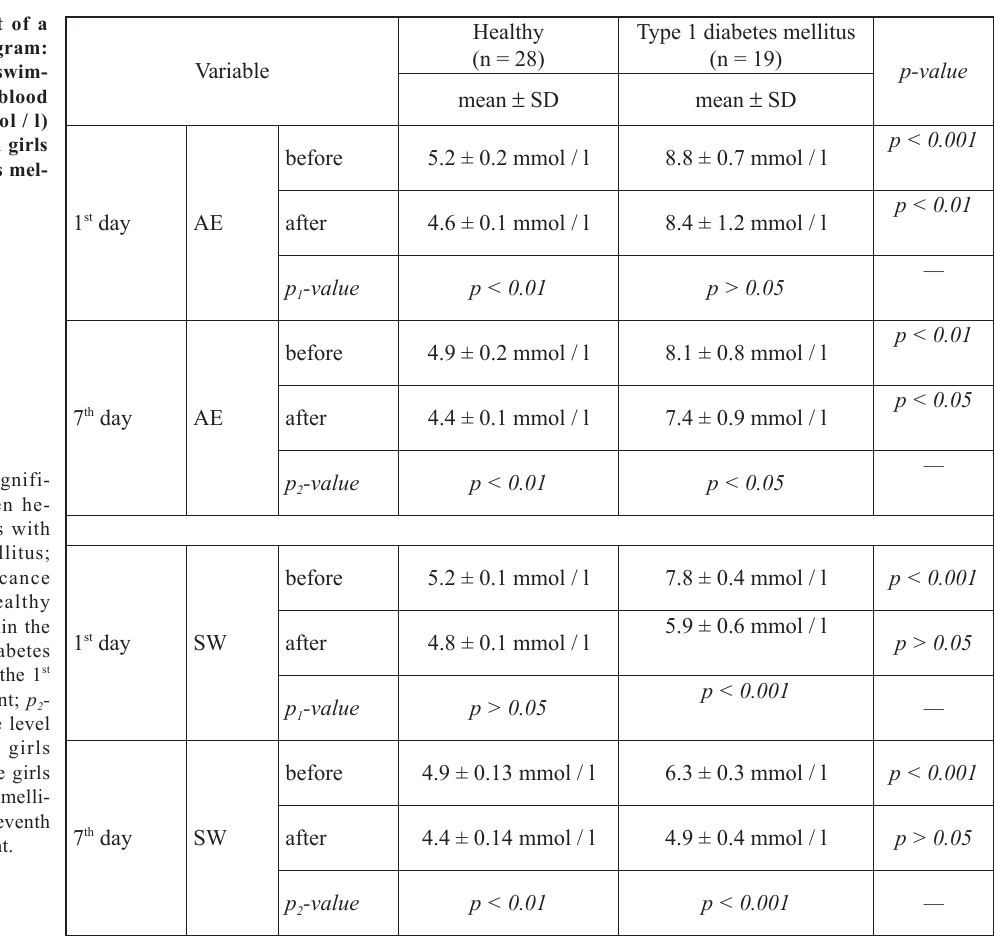
Table 1. Distribution of healthy girls and girls with type 1 diabetes mel- litus who were of normal weight, overweight, and obese, by International Obesity Task Force’s (IOTF) cut off points for body mass index (BMI)